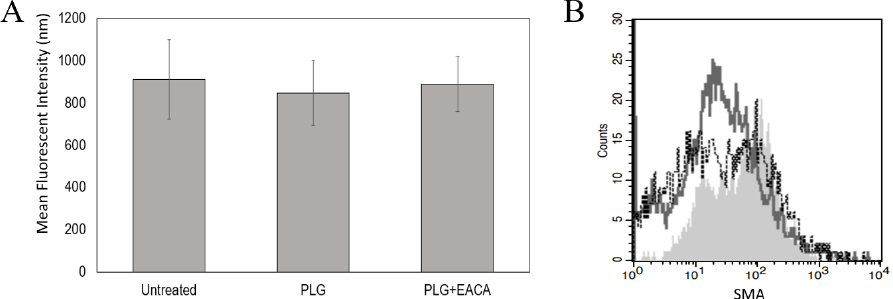
Figure 5. Plg Does Not Affect MeT5A Proliferation or Differentiation. No effect of Lys-Plg on MeT5A proliferation ( A ) and differentiation ( B ) were noted at 48 h post-exposure compared to untreated control cells. ( A ) Proliferation was assessed using CyQuant assays and differentiation measured as increased expression of mesenchymal proteins SMA and vimentin via flow cytometric analyses. ( B ) A representative histogram shows increases in SMA following cell exposure to TGF-beta as a positive control (- - -, unfilled histogram) compared to untreated cells (——, unfilled histogram). However, no significant effect on SMA was noted following cell incubation with Lys-Plg (grey shaded histogram), n =